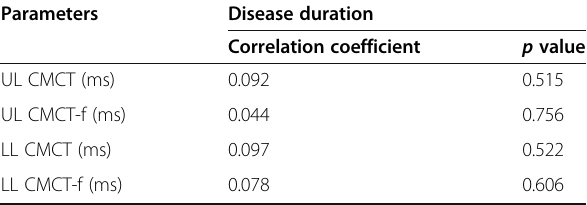
Table 6 Correlation of CMCT and CMCT-f with disease